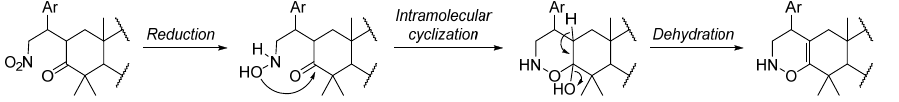
Figure 3. Adopted numbering system, structures of four possible diastereomers I to IV and main NOE effects (